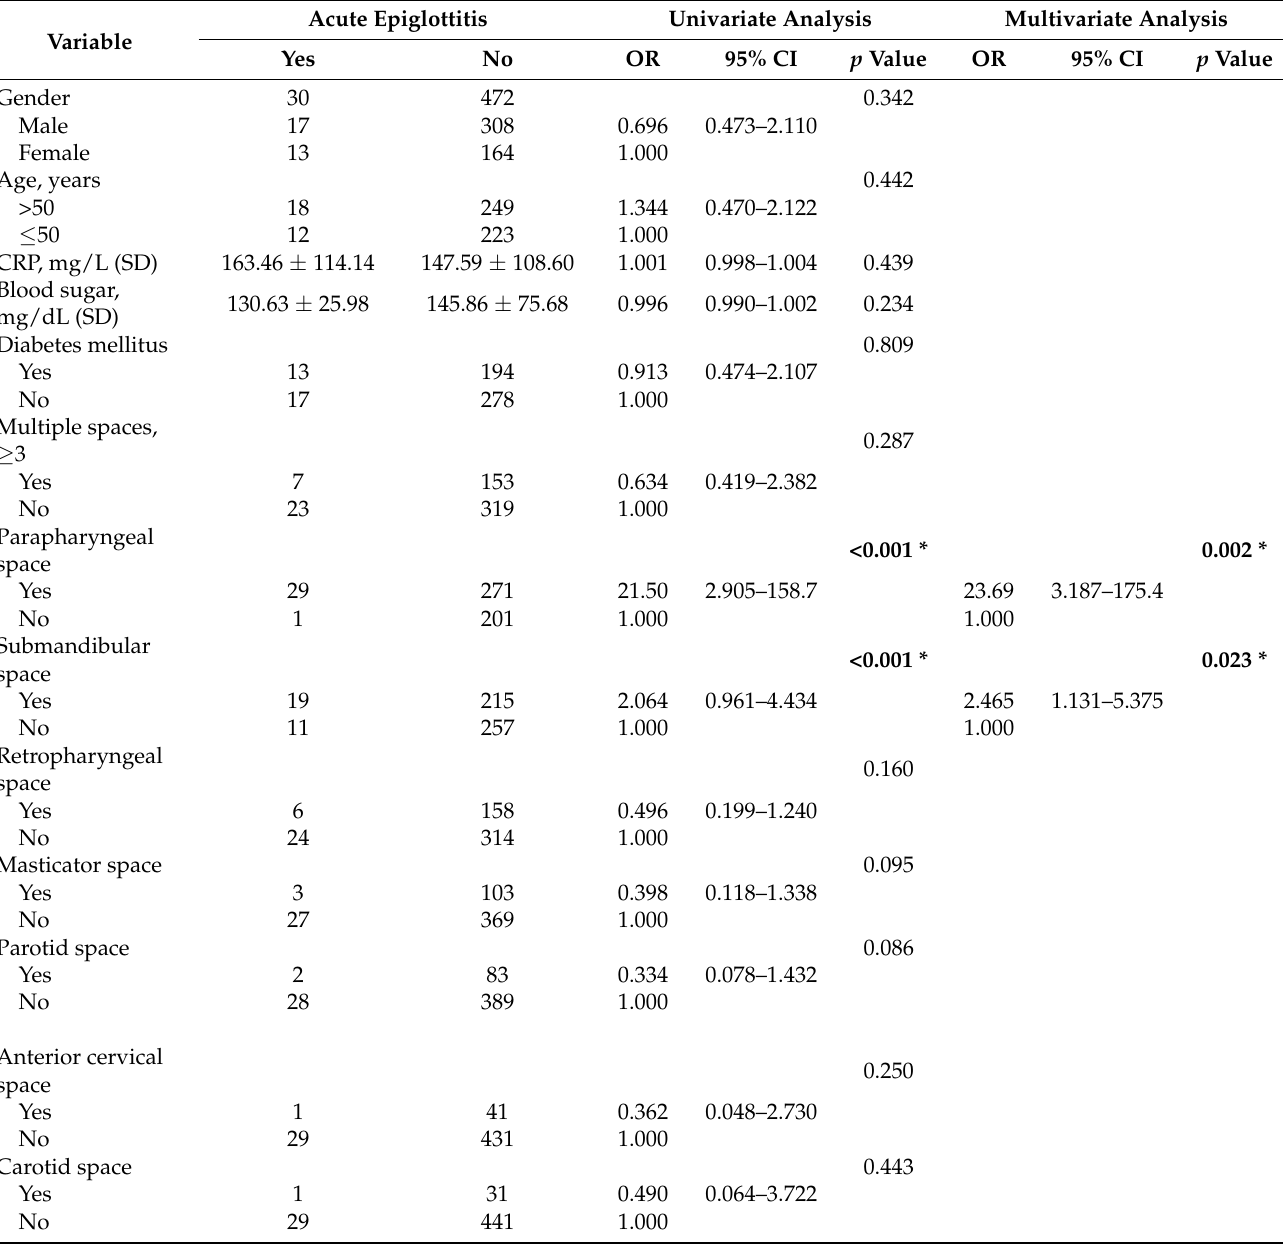
Table 2. Univariate and multivariate analyses of 30 cases of concurrent acute epiglottitis in 502 patients with deep neck